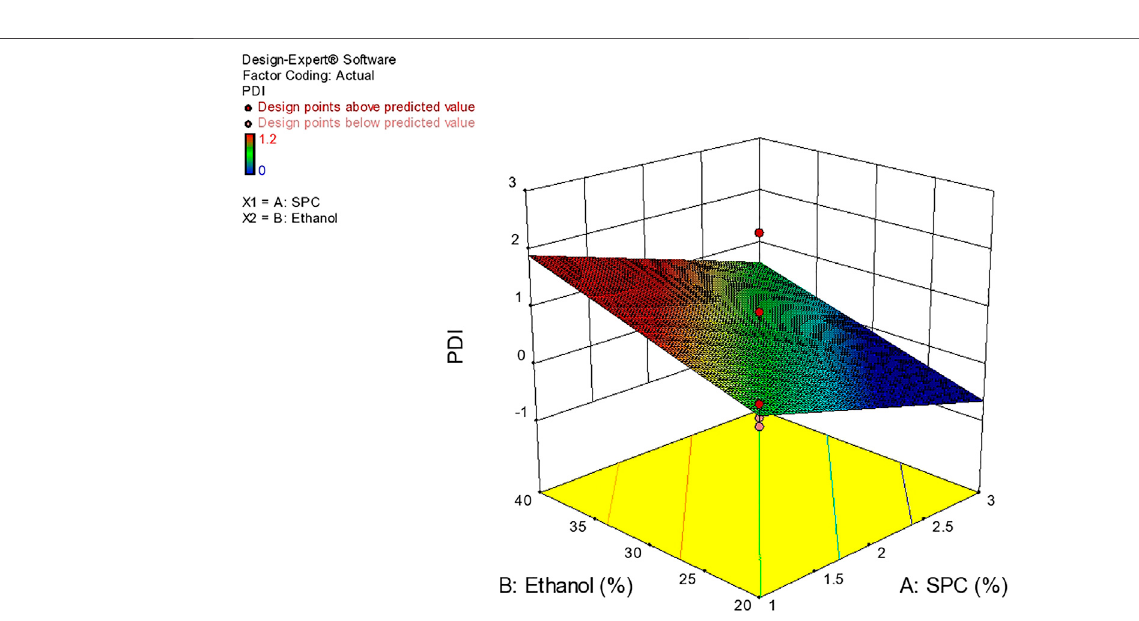
FIGURE 8 | Response surface plot showing effect of ethanol and lipid on